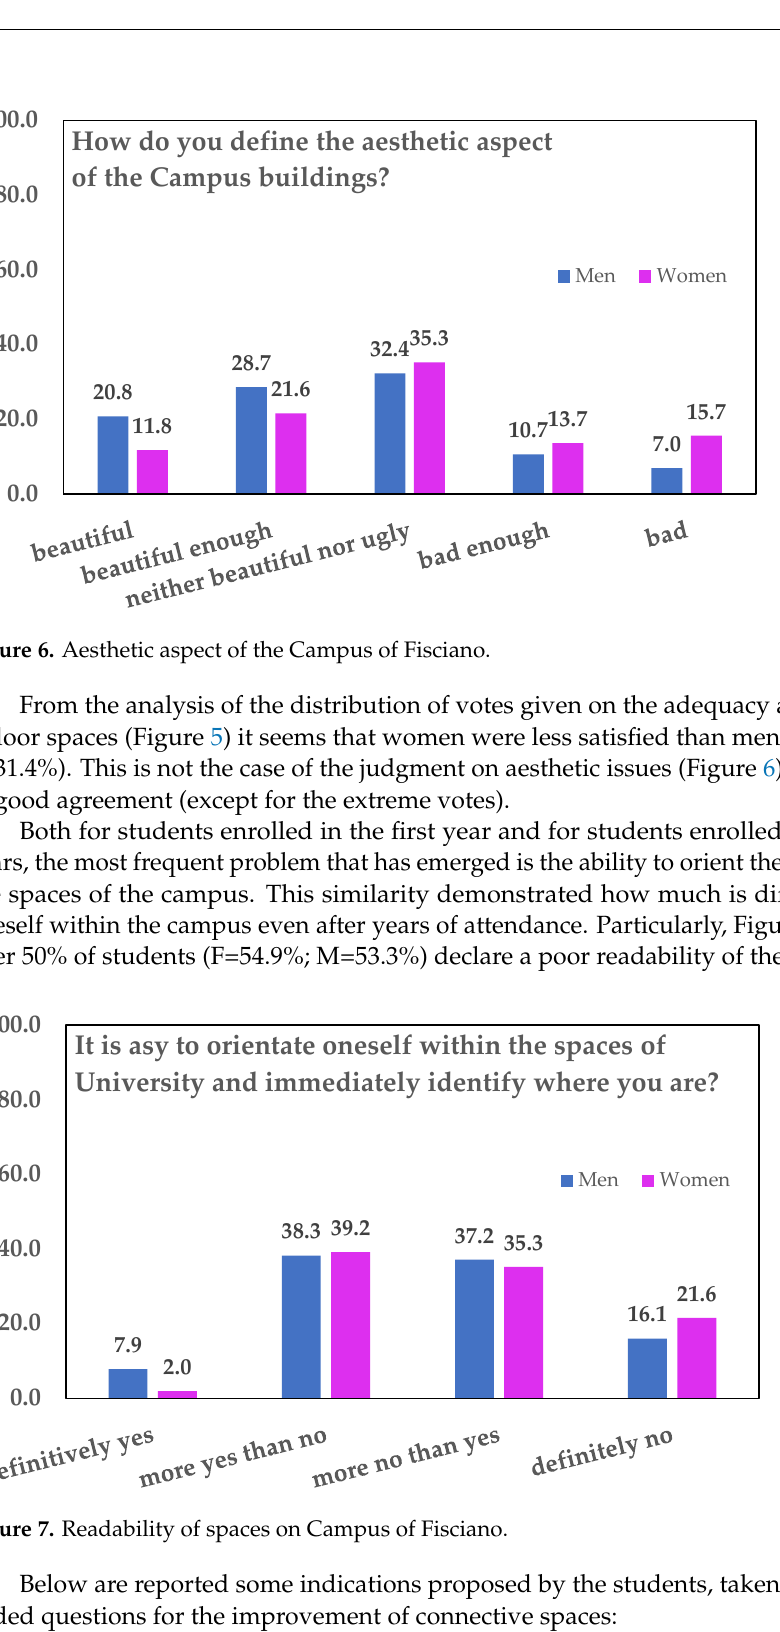
Figure 5. Adequacy and comfort of classrooms.